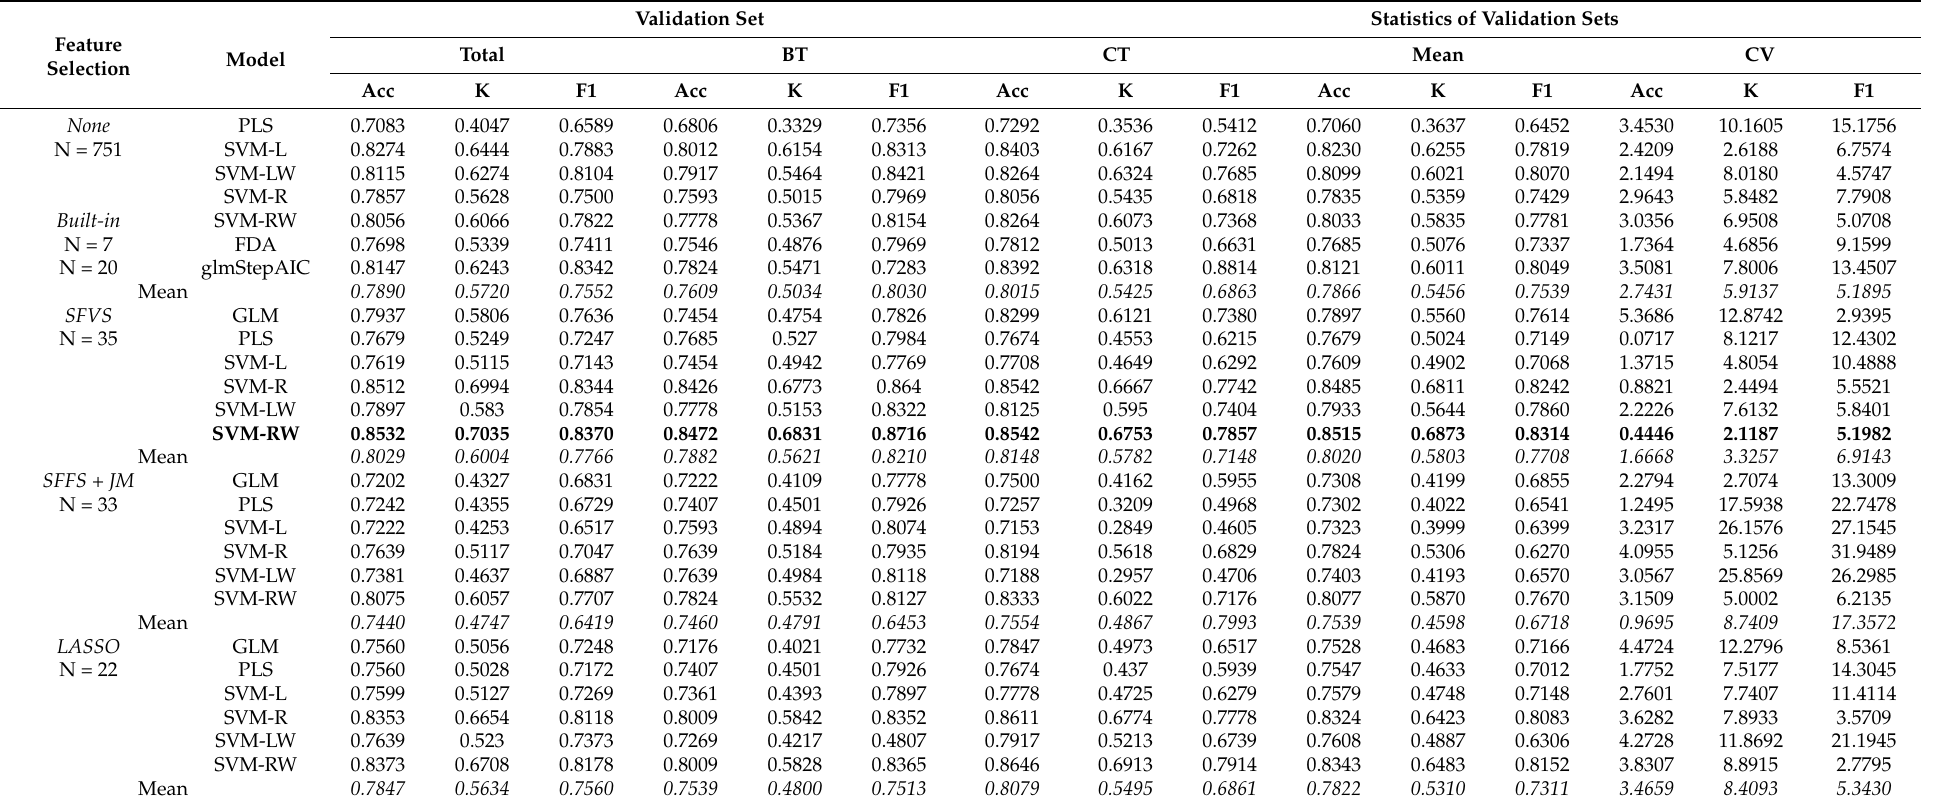
Table 2. Validation results for models classifying bacterial canker of kiwi (BCK)